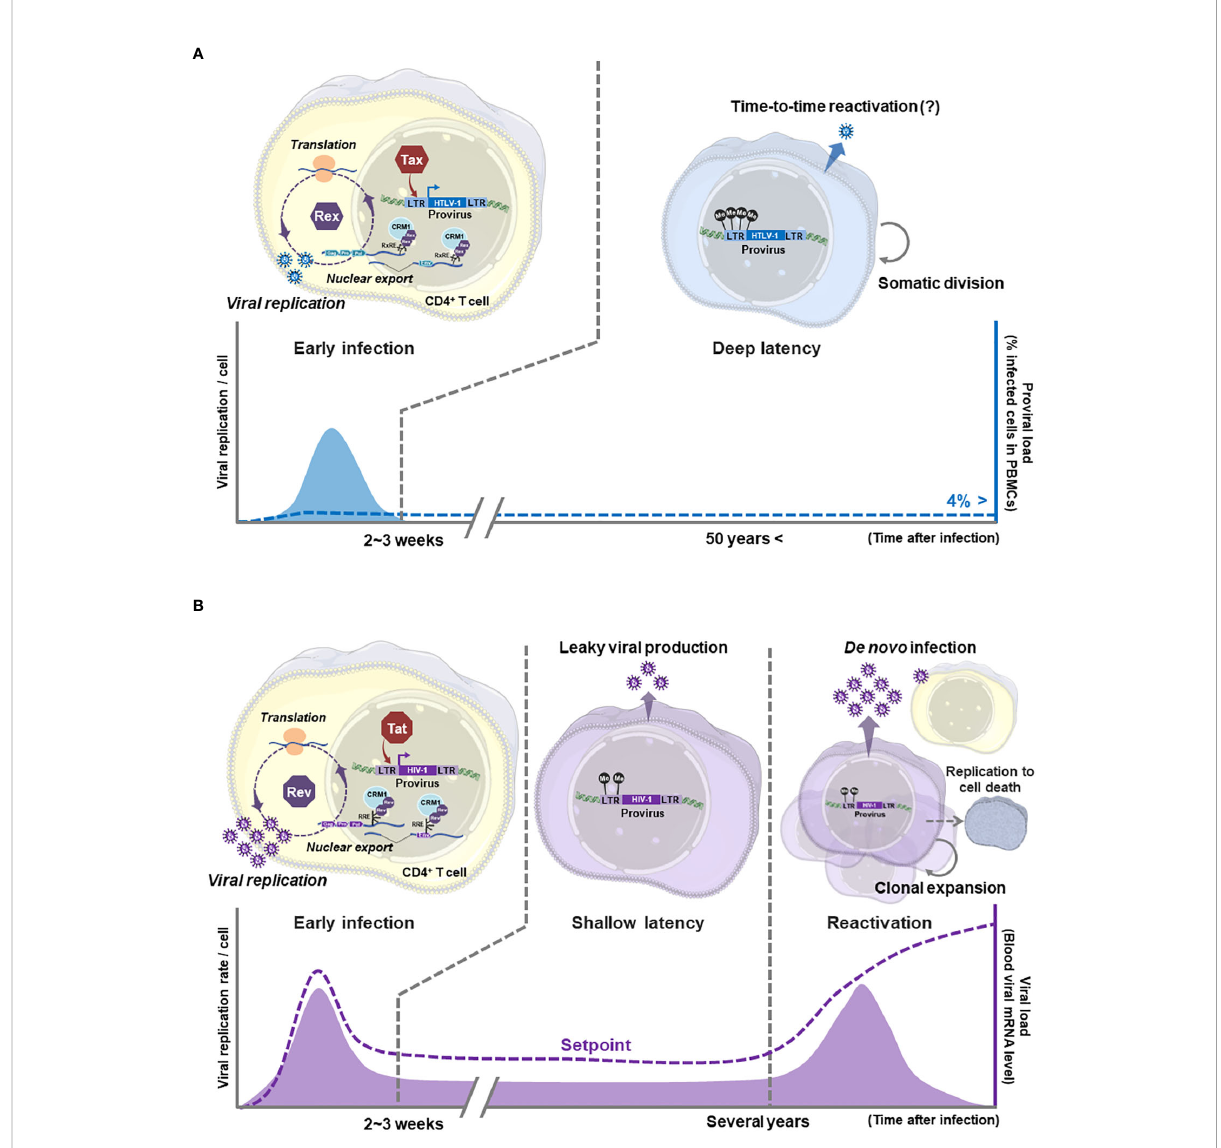
FIGURE 2 Comparison of HTLV-1 and HIV-1 viral replication modes: (A) In the early state of HTLV-1 infection to T cells, Tax and Rex are expressed from the provirus to start viral gene expression. Tax activates the viral promoter 5 ′ LTR (as L.545) and enhances transcription of unspliced/singly spliced mRNAs encoding viral structural proteins. Rex nuclear exports those unstable, not-completely spliced viral RNAs via the RxRE/CRM1 dependent mechanism to enhance the translation of viral structural proteins, thus the production of virions. In HTLV-1 infected cells, such active virion replication is expected to be brought to the end within a few weeks. Then HTLV-1 infected cells transit to the latency with immortalization, although the molecular mechanism of immortalization has not been clari fi ed. The immortalized HTLV-1 infected T cell maintains the deep latency (transcriptional latency) without active viral gene expression for decades. Somatic infected-cell division and temporal virion production may occur to maintain the infected cell number in asymptomatic carriers. The ProVL is the % of provirus-carrying inactive infected cells in PBMCs of an infected individual (blue dashed line). (B) HIV-1 also undergoes active viral particle replication through Tat- mediated activation of 5 ′ LTR (as L.545) and nuclear export of unspliced/singly spliced viral mRNAs by Rev/RRE/CRM1 dependent mechanism. The active viral replication in infected cells and de novo infection via viral particles quickly increase the viral load (VL: the number of HIV-1 mRNAs in a carrier body=the blood level of virus particles, purple dashed line) to the peak level within a few weeks in the acute infection phase. After the acute infection, the infected cells are quickly eliminated leaving a small number of long-lived memory CD4 + T cells as the reservoir. The reservoir cells are expected to produce virions at a low level during the (shallow) latent infection, therefore the VL is reduced to the setpoint (no disease-inducing level), but never becomes undetectable level in untreated carriers. Without treatment, the reservoir cells are reactivated within a few years and clonally expanded by immunological stimuli. Reactivated cells produce a vast number of viral particles, resulting in an explosive increase in the number of newly infected T cells and the VL. The viral particle production is continued until the host cells die, thus the number of functional CD4 + T cells is depleted to cause the onset of AIDS. Generated using Servier Medical Art, provided by Servier,